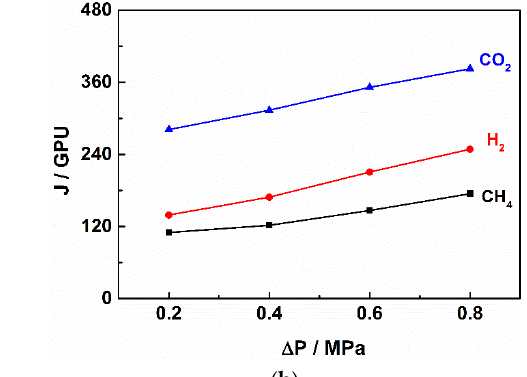
Figure 7. Effects of operating pressure on membrane performances. ( a ) PI membrane gas permeation rates; ( b ) PDMS/PEI membrane gas permeation rates.